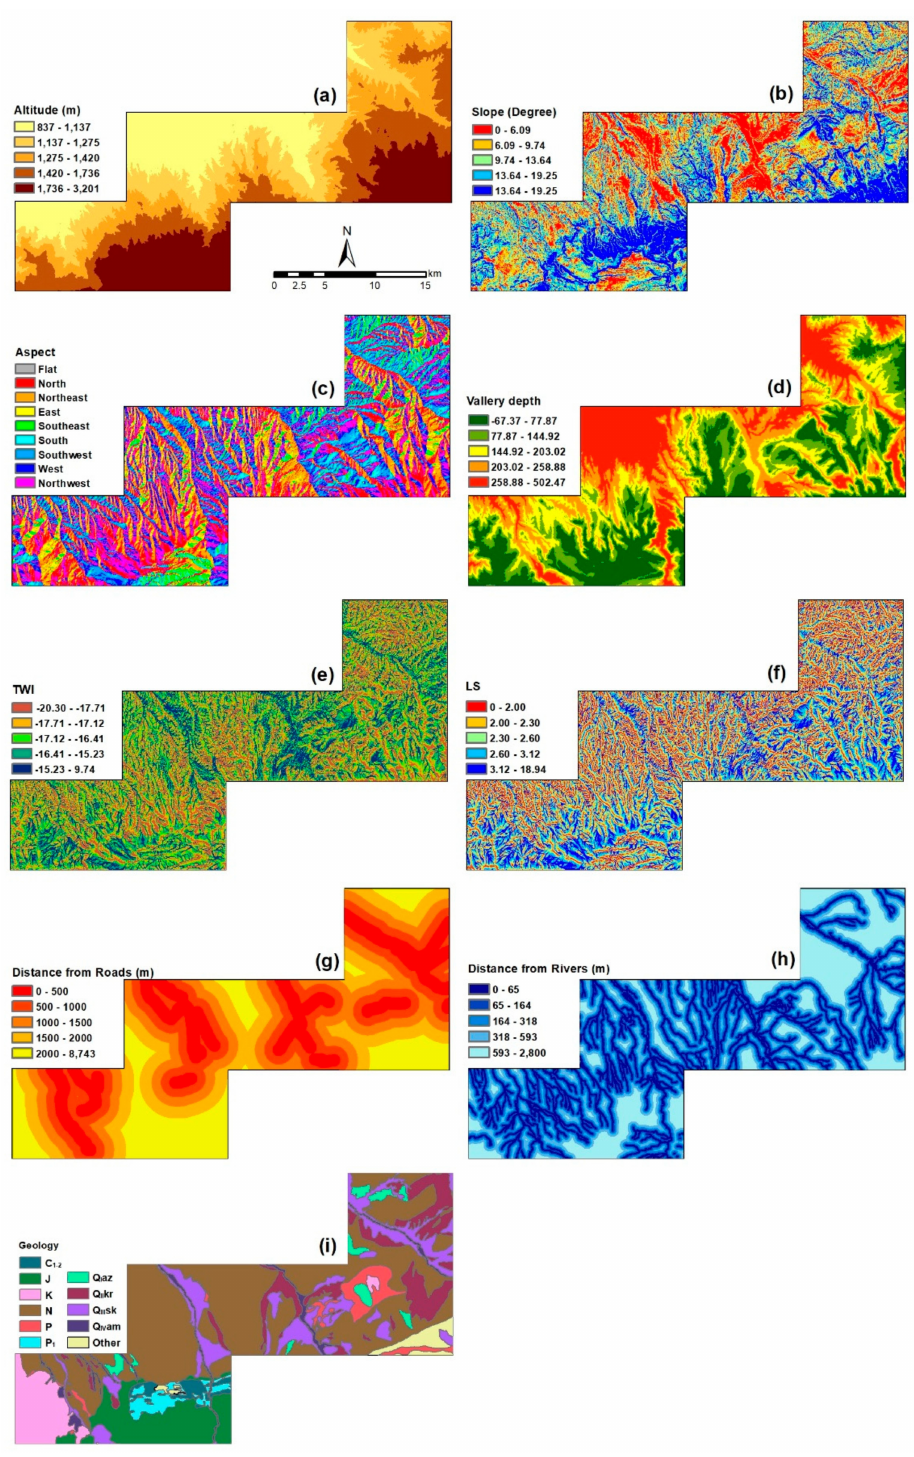
Figure 3. Landslide conditioning factors in the study area: ( a ) Altitude; ( b ) Slope; ( c ) Aspect; ( d ) Valley Depth; ( e ) TWI; ( f ) LS; ( g ) Distance from Roads; ( h ) Distance from Rivers; ( i )